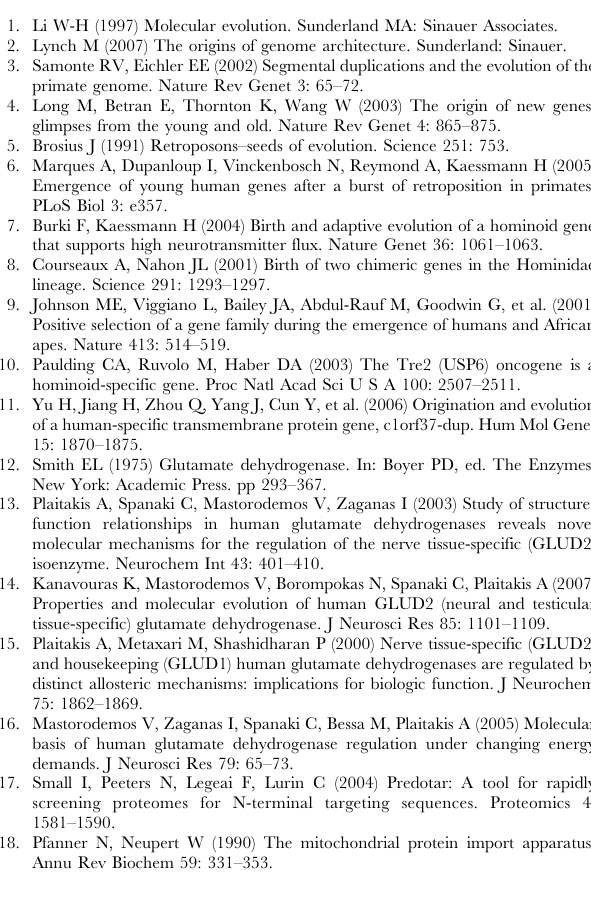
Figure S3 Subcellular Localization of Human GLUD1 and GLUD2 from Apes. See legend of Figure 3 and main text for details. Figure S4 Subcellular Localization of Wild Type and Mutant GLUD MTS-GFP Fusion Proteins. See legend of Figure 4 and main text for details. Figure S5 Subcellular Localization of Wild Type and Mutant GLUD1/GLUD2 MTS-GFP Fusion Proteins. See legend of Figure 5 and main text for